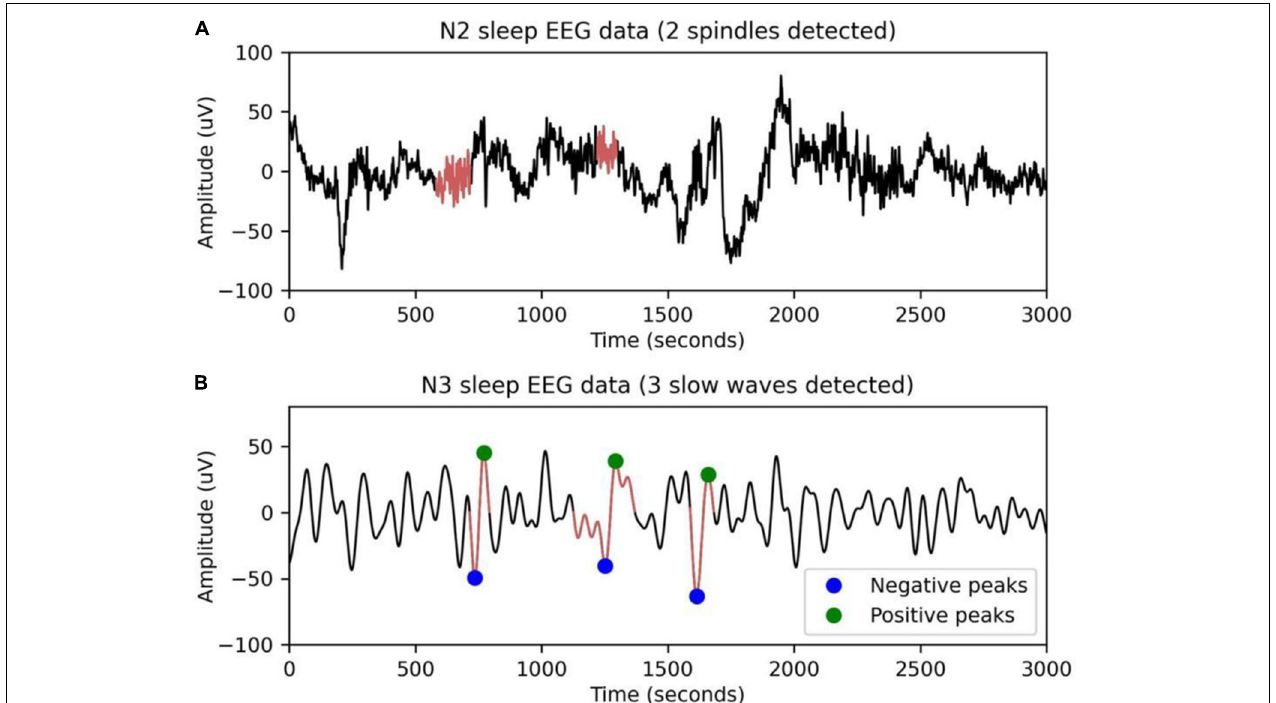
FIGURE 2 | EEG waveforms detected during 30-s NREM sleep (A) spindles and (B) slow sleep